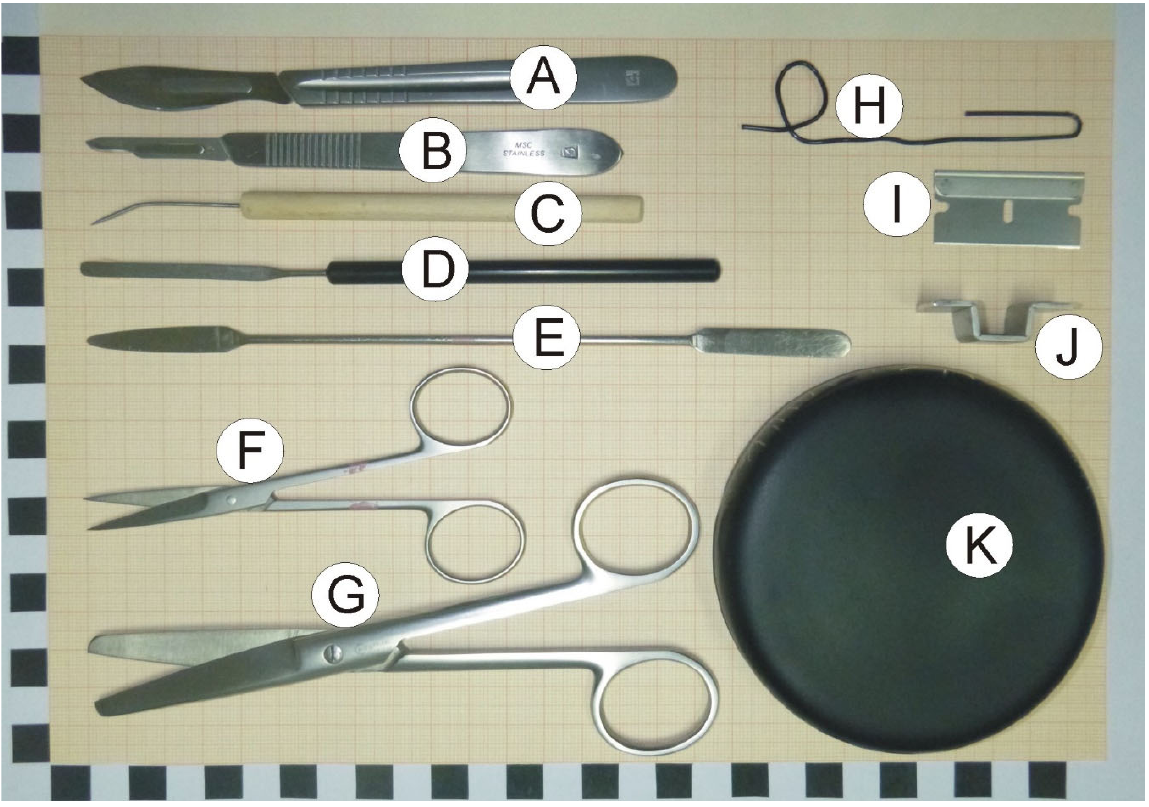
Figure 1. Dissection tools placed on millimeter paper. The black and white scale on the borders of the image is expressed in centimeters. For more information, please see Section 2.2.